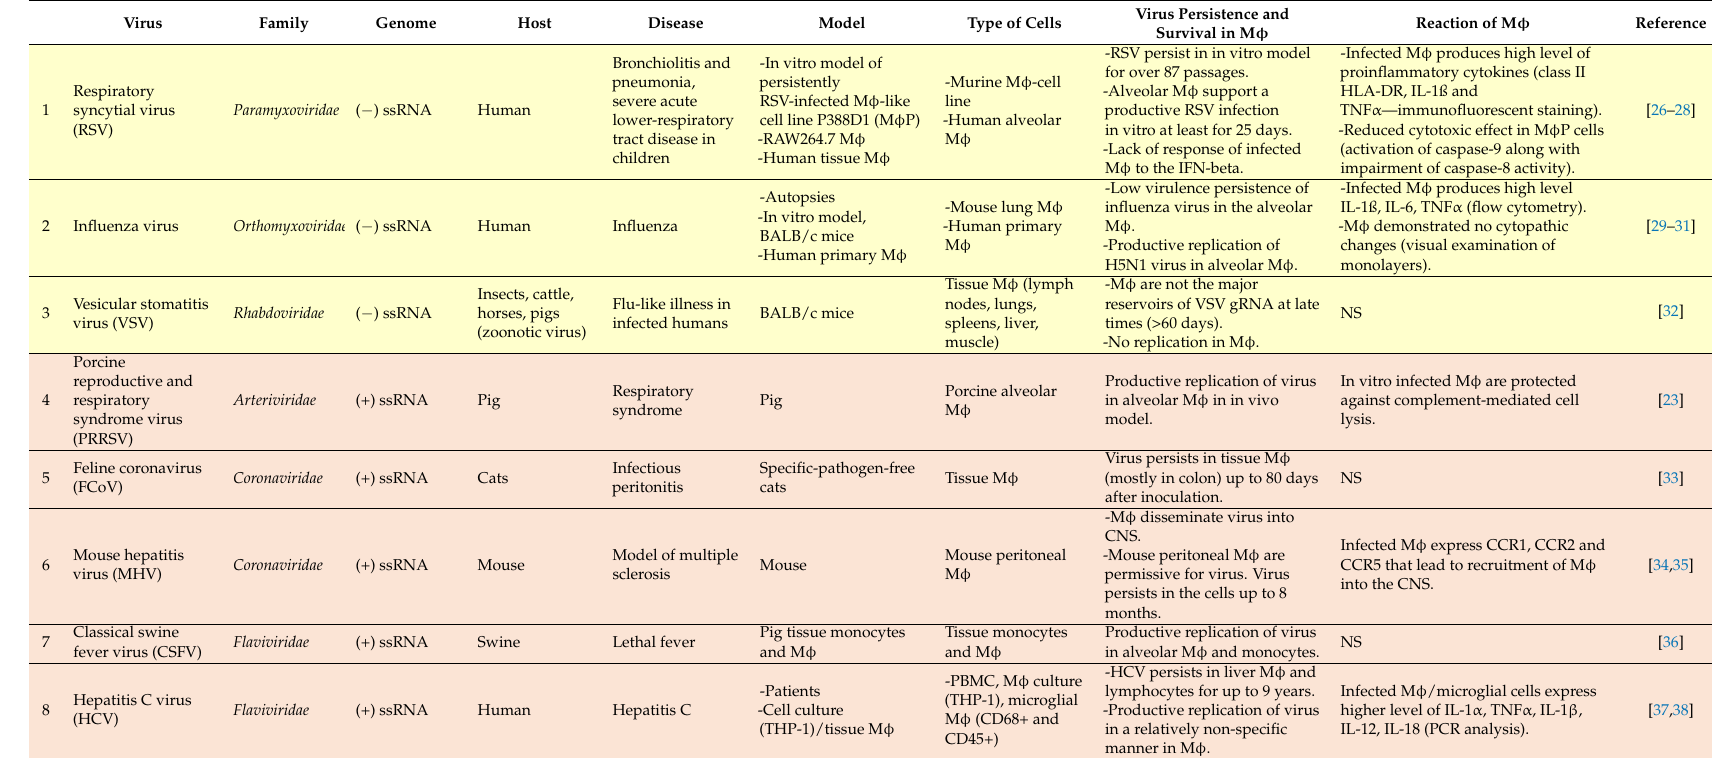
Table 1. Viruses affecting monocyte/macrophage cells.